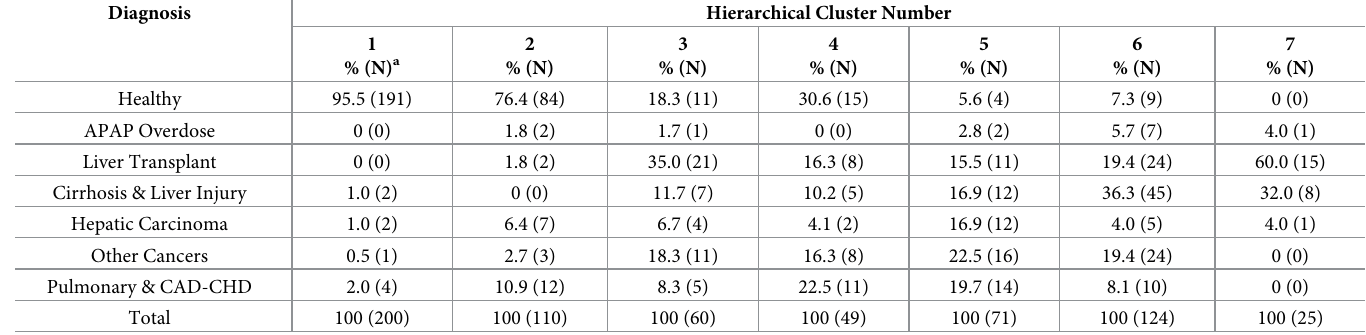
Table 4. Distribution of subjects by hierarchical